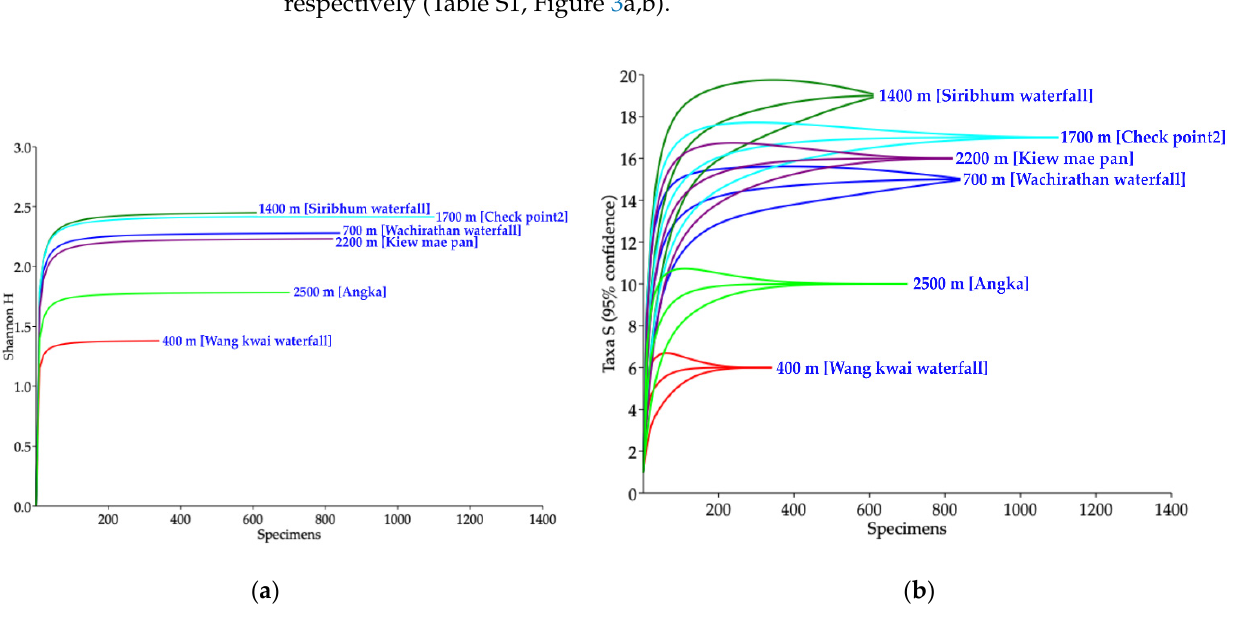
Figure 3. Biodiversity comparison of black flies collected among six collection sites in Doi Inthanon National Park. ( a ) Individual-based rarefaction curves (Shannon_H index), and ( b ) species richness.